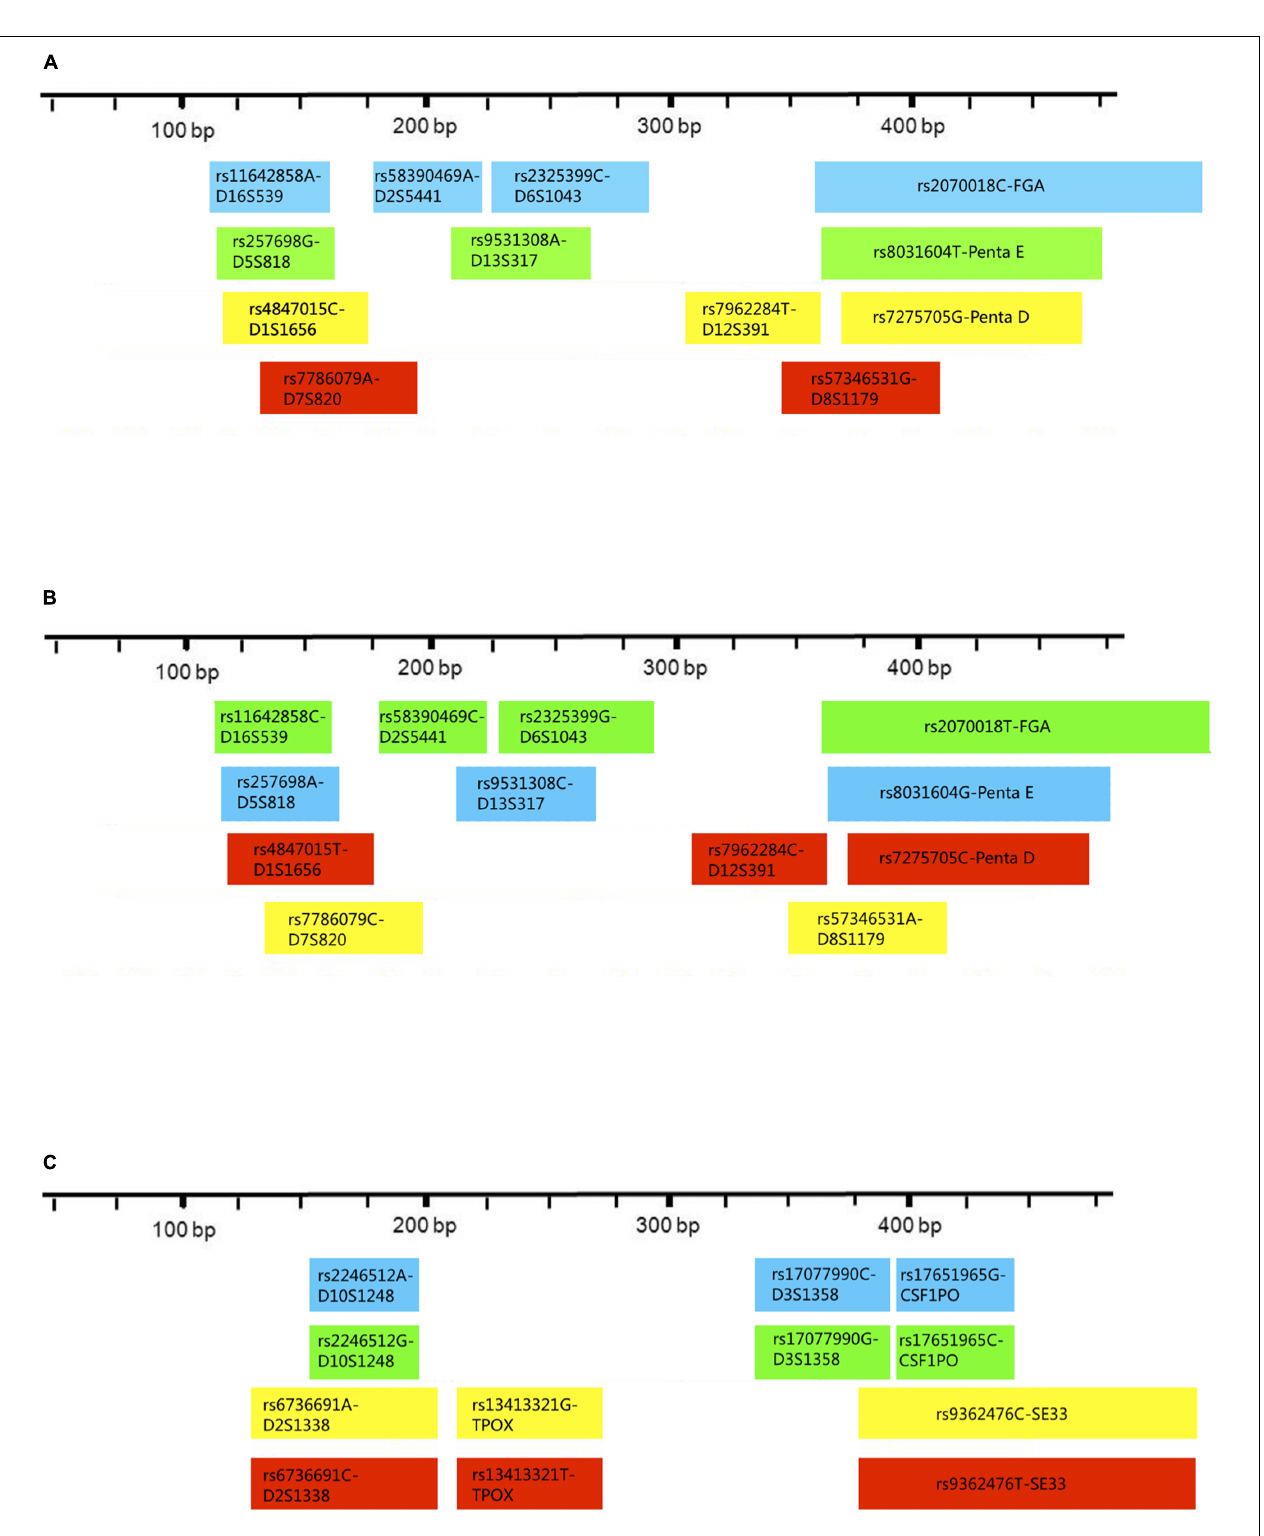
FIGURE 3 | Distribution and fluorescent-dye colors of SNP allele-specific primers for 18 SNP-STRs in multiplex panels. The multiplexes consist of Panel-A , Panel-B , and Panel-C . Each block represents one pair of allele-specific forward and reverse primers of an SNP-STR locus, the width of each block indicates the length range of amplicons, and the color indicates peak color from the fluorophore label of each allele-specific primer in the profiles.